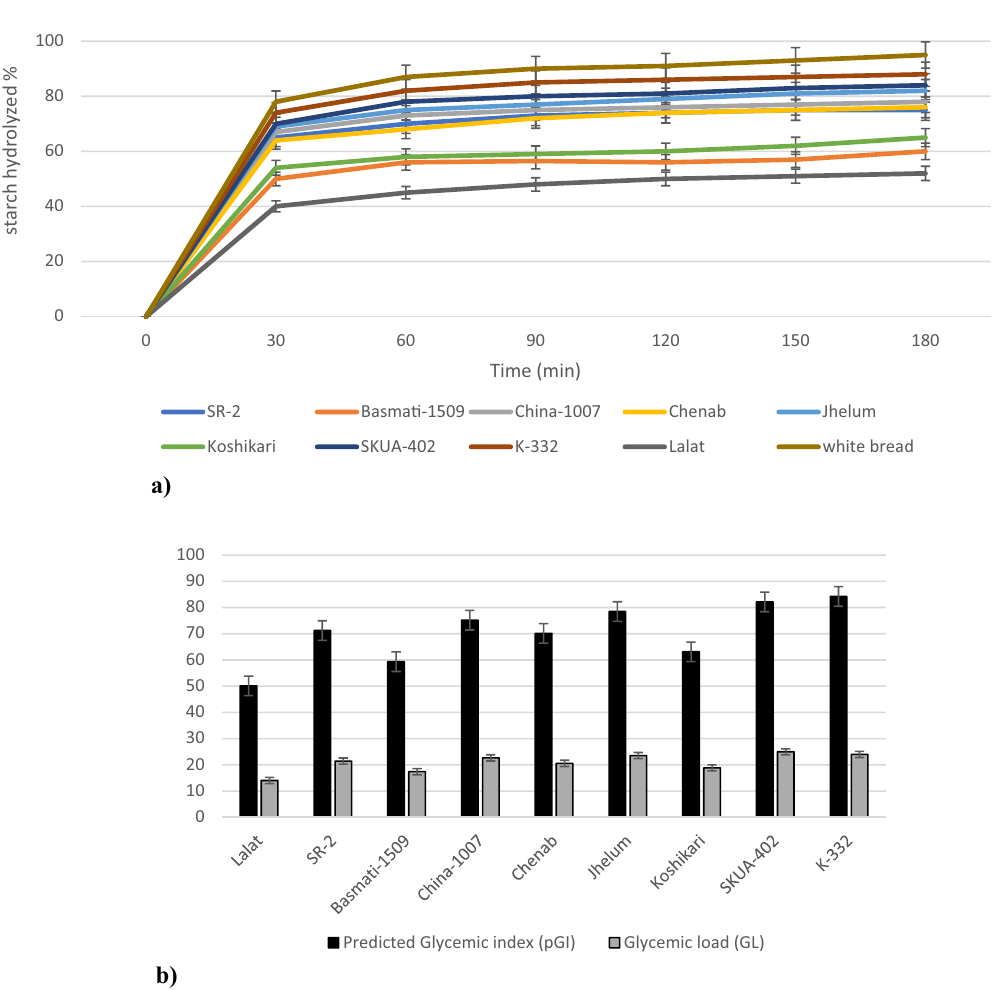
Figure 2. ( a ) Kinetics of starch hydrolysis of rice varieties from 0 to 180 min. ( b ) Predicted glycemic index and glycemic load of different rice